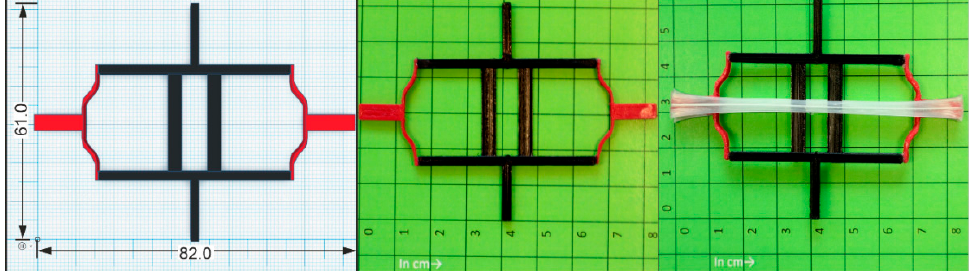
Figure 11. Unit cell consisting of an elastomeric material (Desmopan ® 9370AU, red color) and a stiff material (PET-G, black color): Technical drawing ( left , all data are provided in mm.), additively manufactured unit cell (in the middle ) and state after installing the actuator element (whitish color, right ). Centimeter paper was used as a base in the second and third image.